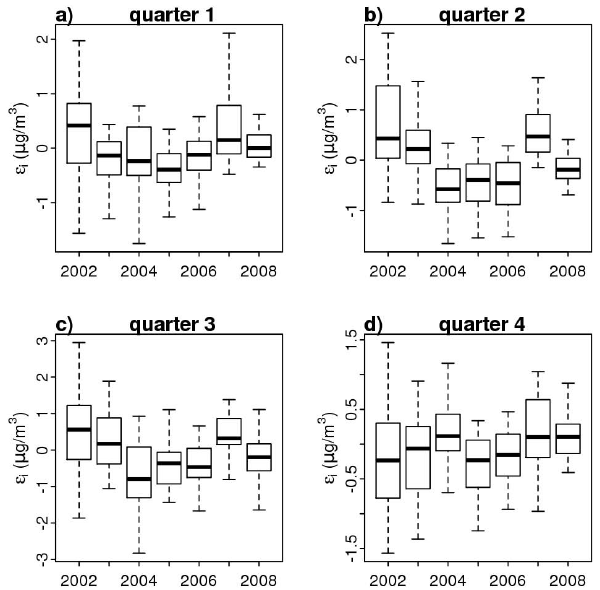
Fig. 6. Lack of systematic change in residual error values ( ε i ) be- tween 2004 and 2005 at the Sipsy Wilderness in Alabama, a site with one of the highest OC concentrations. Inspection of the analo- gous plots from other sites reveals no abrupt change in ε i